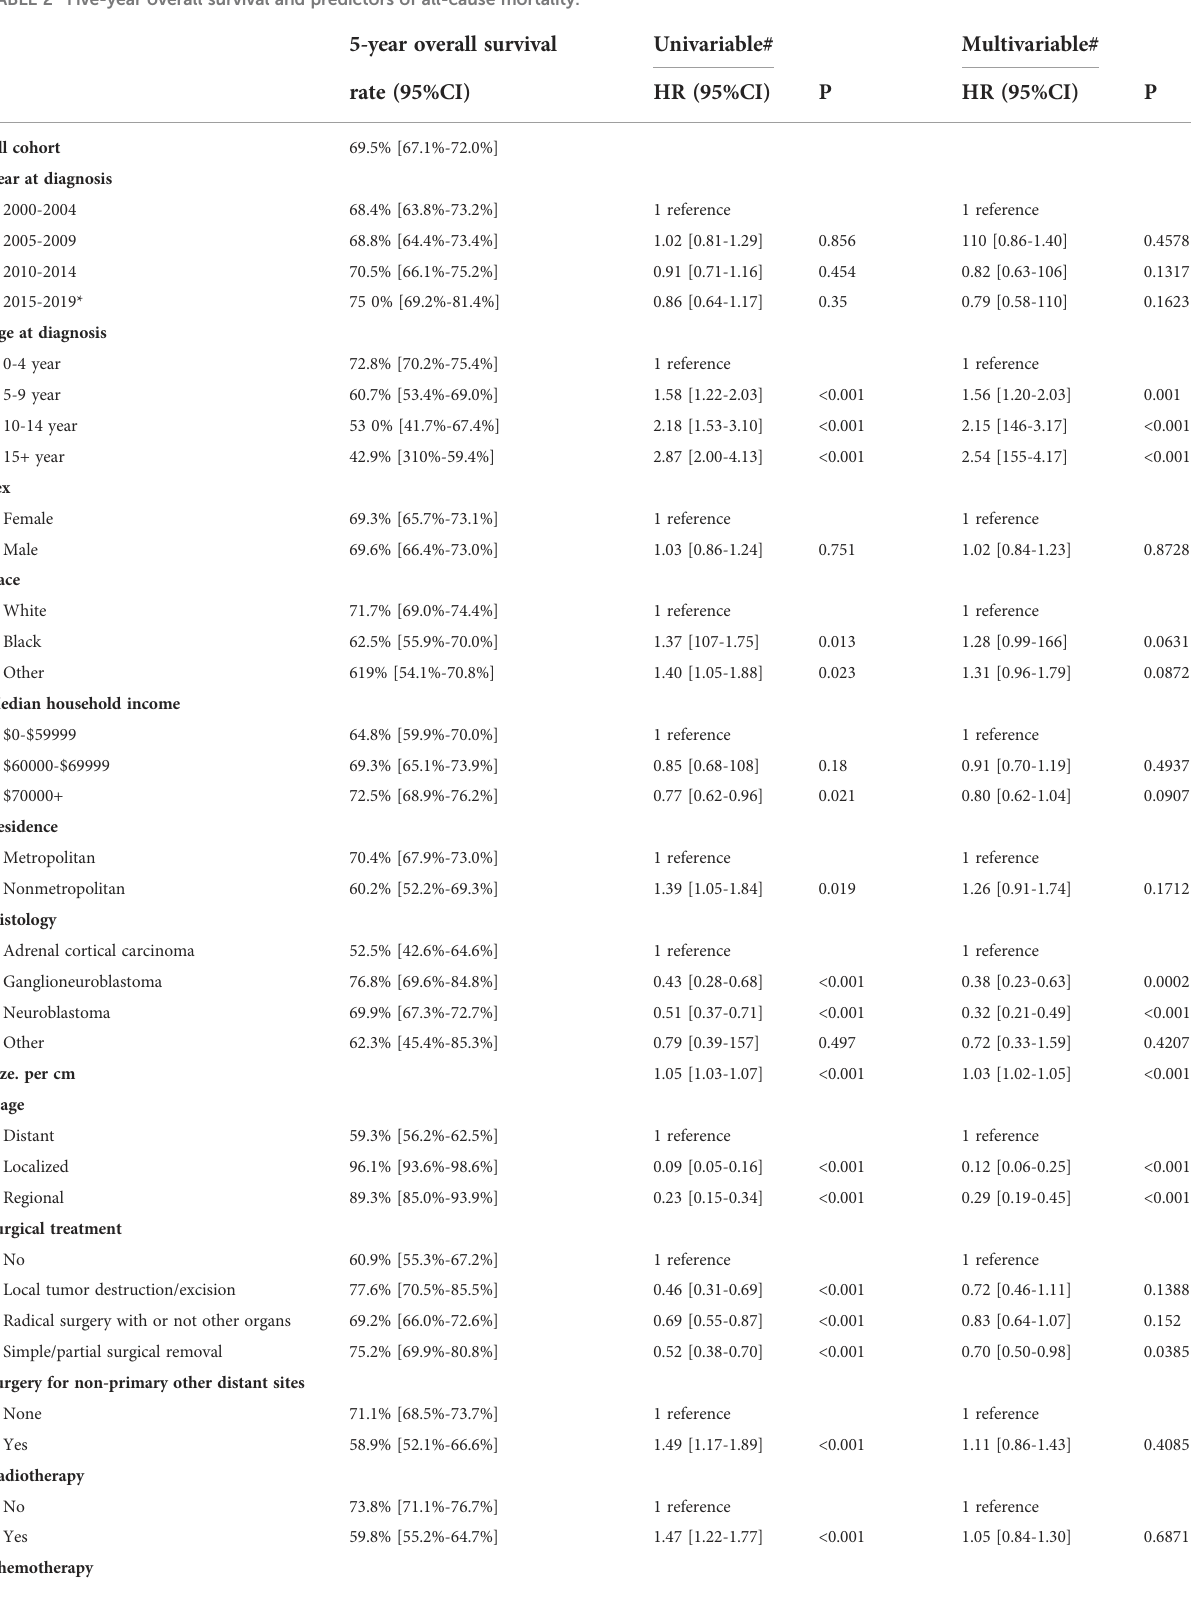
TABLE 2 Five-year overall survival and predictors of all-cause